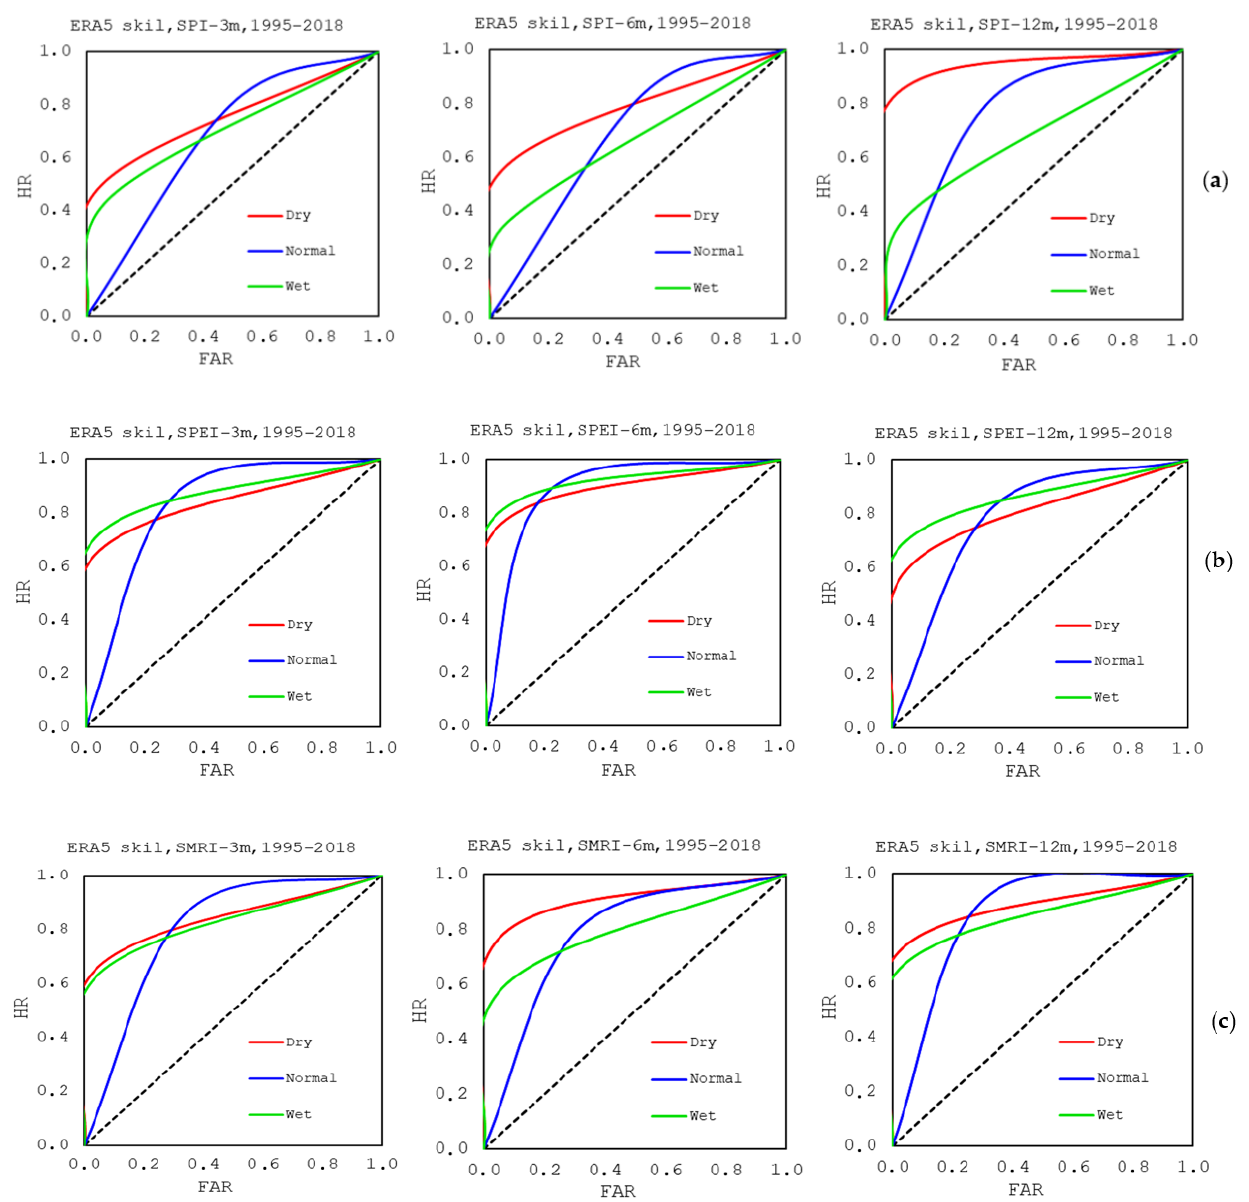
Figure 5. ROC curve for SPI ( a ), SPEI ( b ), SMRI ( c ) for three classes of dry, wet and normal drought conditions over ULB.